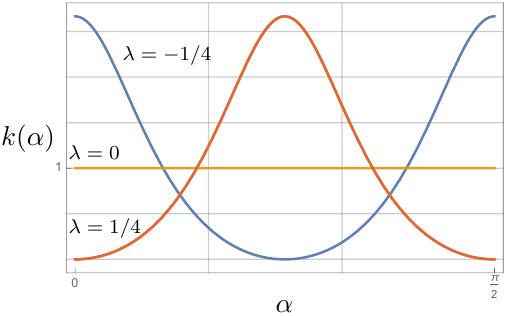
Figure 2 . The function k ( (cid:11) ) for three di(cid:11)erent values of (cid:21) . The function is (cid:25)= 2 periodic and should be extended to cover the entire range 0 (cid:20) (cid:11) (cid:20) 2 (cid:25) . As j (cid:21) j approaches 1 the function gets concentrated around the peaks at (cid:11) = 0 + n(cid:25)= 2 for (cid:21) ! (cid:0) 1 and (cid:11) = (cid:25)= 4 + n(cid:25)= 2 for (cid:21) ! 1, where n 2 Z